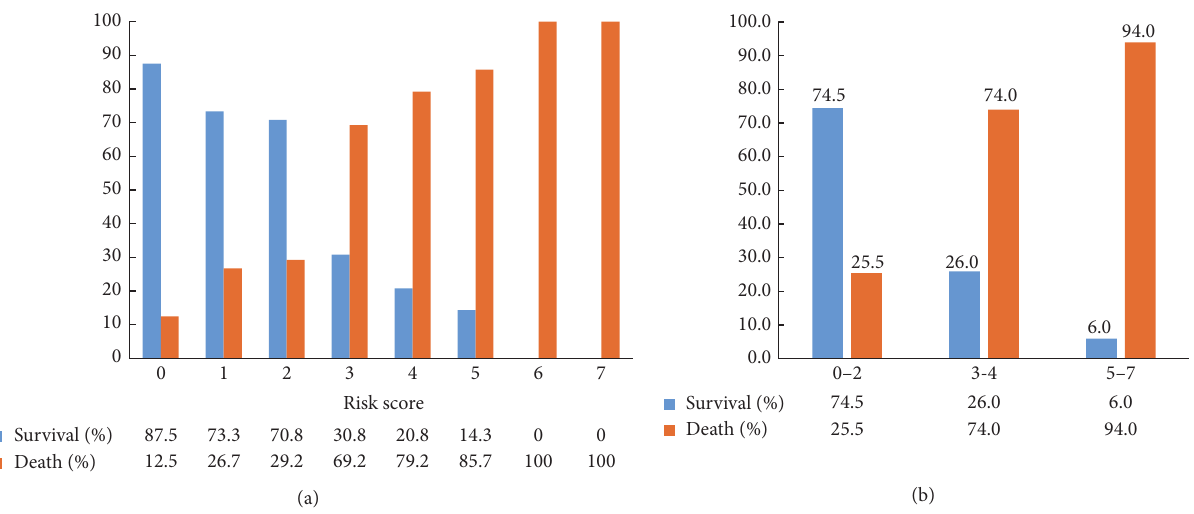
Figure 6: (a) The survival and mortality rate of patients in each score. (b) The survival and mortality rate of patients in stratified score groups.